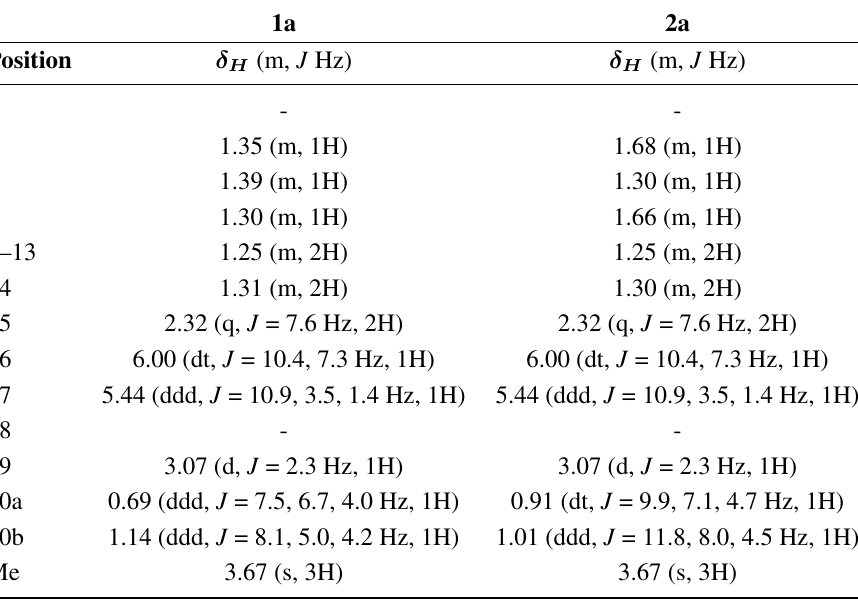
Table 2. 1 H NMR spectroscopic data (CDCl , (cid:14) in ppm) of 1a and 2a . 3 1a